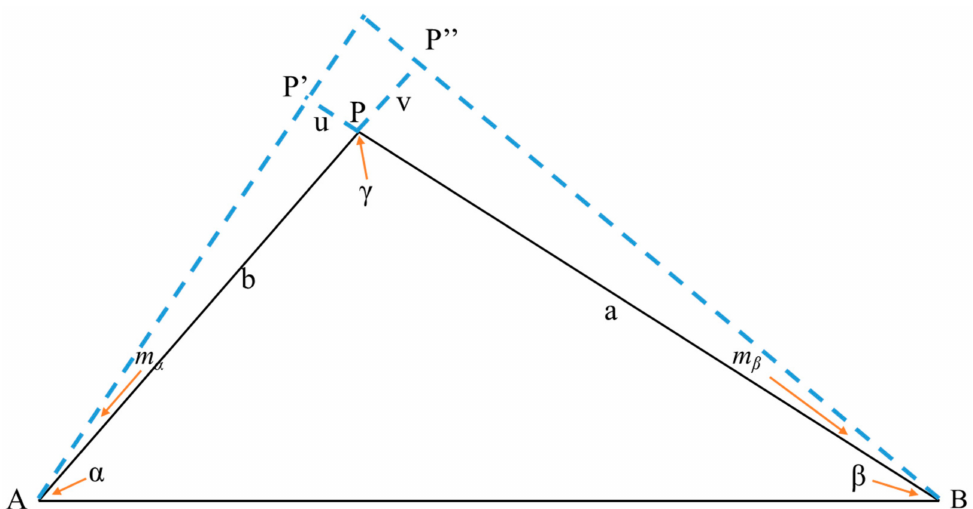
Figure 4. Measurement accuracy derivation schematic diagram. The control points are A and B